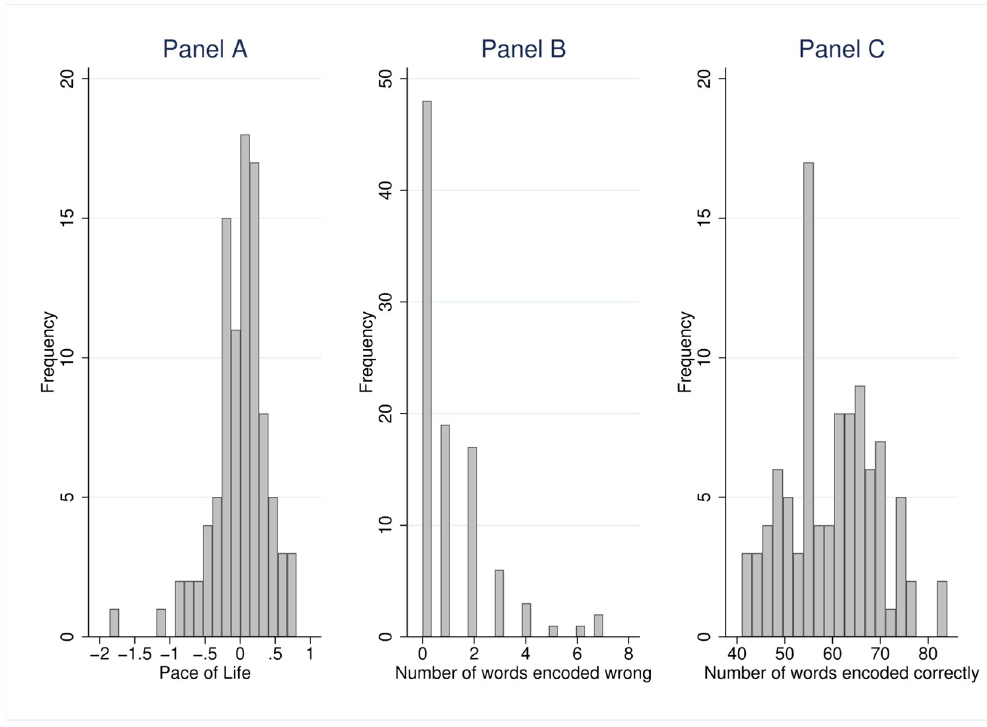
Fig 2. Histogram for the distribution of the variables measuring individual Pace of Life , errors and